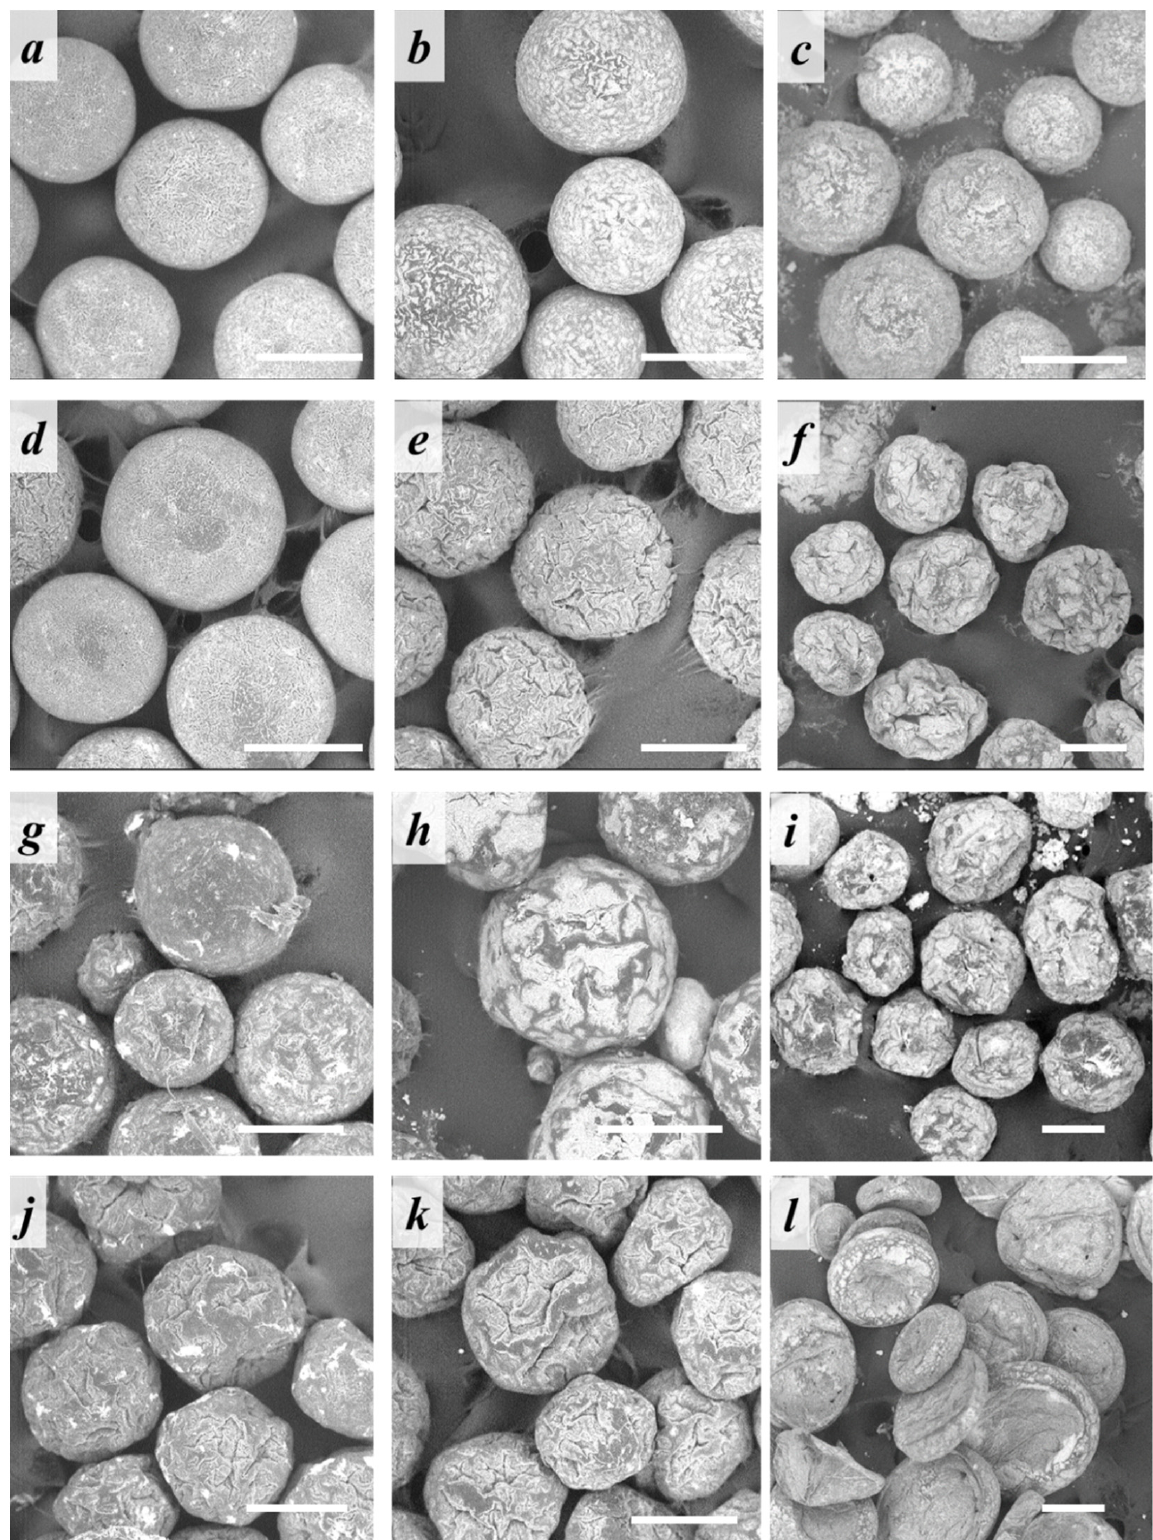
Figure 4. SEM micrographs of core/shell microparticles based on ( a – f ) PLA or ( g – l ) PCL stabilized with ( a , d , g , j ) 0.1, ( b , e , h , k ) 0.5, or ( c , f , i , l ) 1 wt.% of nHA in the aqueous phase ( a – c , g – i ) without or ( d – f , j – l ) with preliminary US treatment of the water nHA dispersion. Scale bar: 200 µ